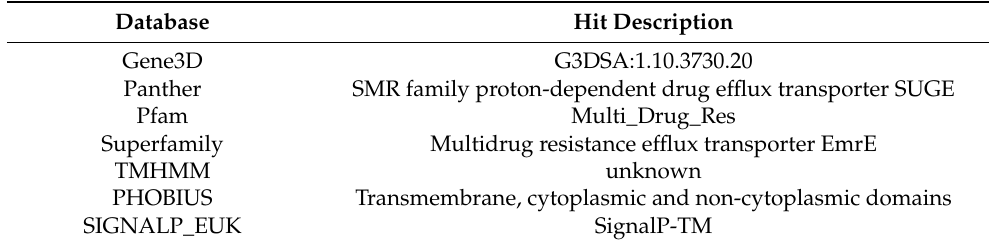
Table 4. InterProScan database hits on DLP1 and DLP2 EmrE. The data represent findings for both phages due to duplicate search